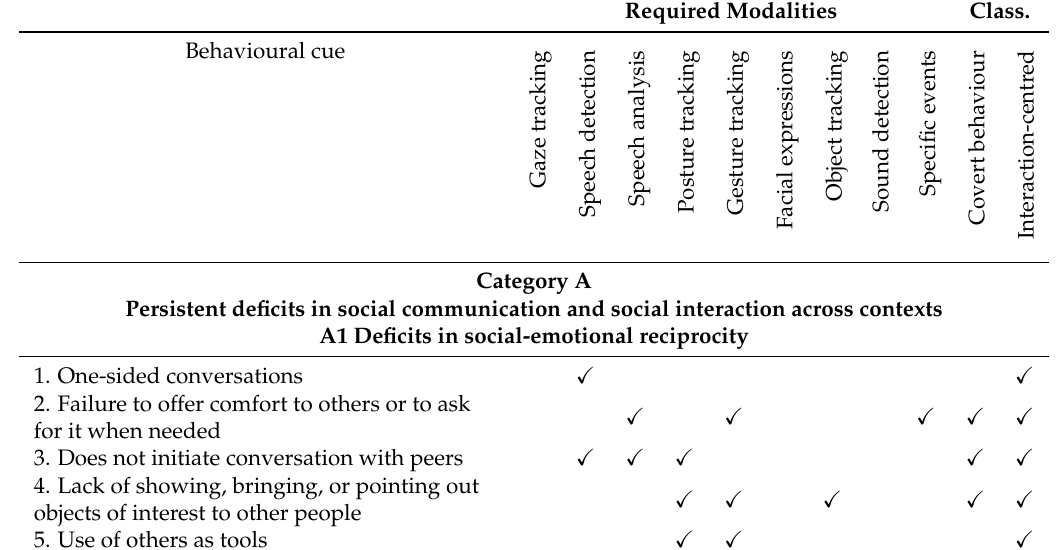
Table 1. Detailed breakdown of the behavioural cues for Category A that a therapist might use in ASD diagnosis based on DSM-5 criteria, and the corresponding required modalities.